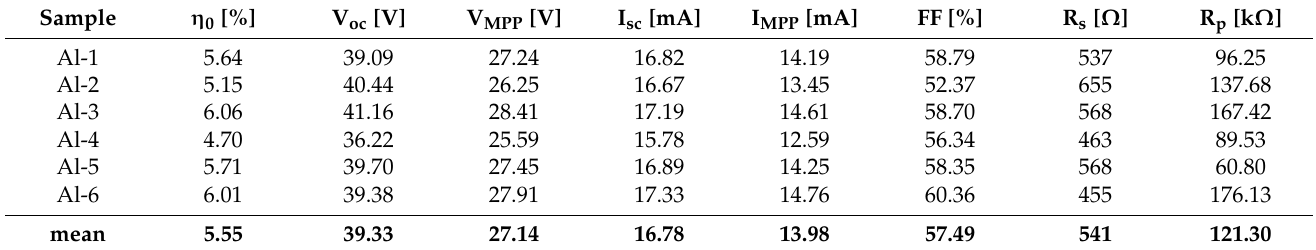
Table 1. Key parameters of the six submodules, investigated in this study: efficiency η 0 , measured